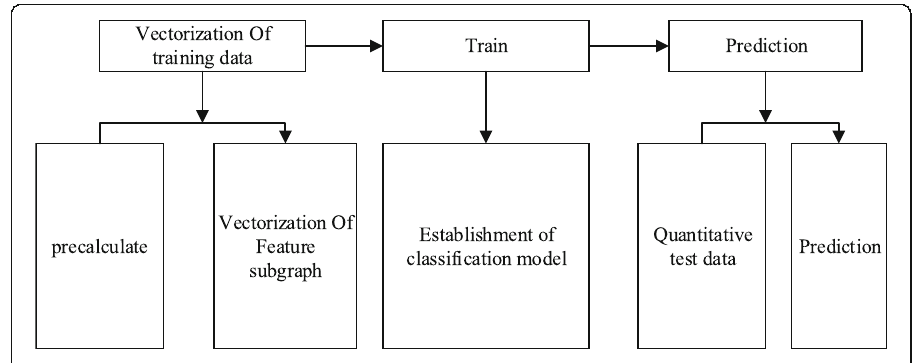
Fig. 2 Steps of classification calculation method